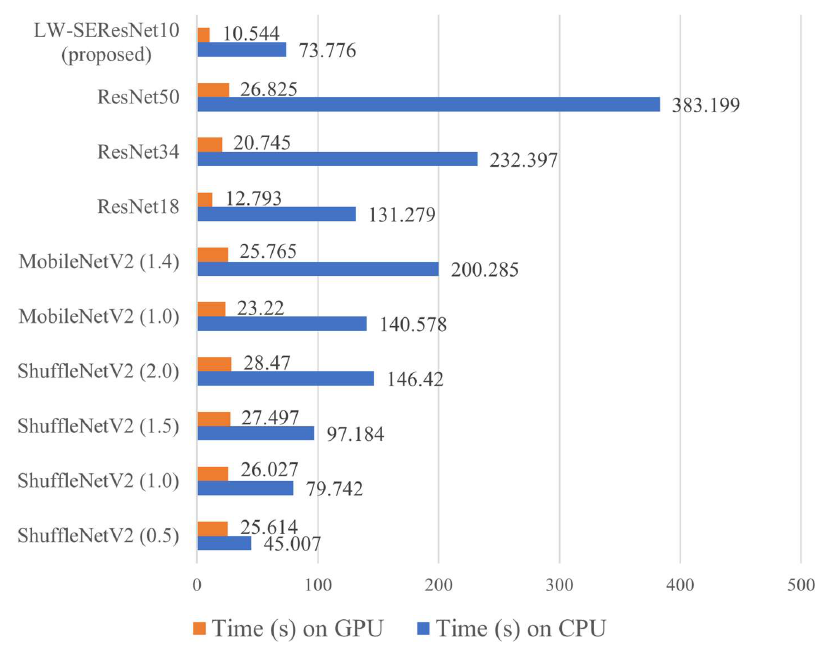
Figure 8. The training time of multiple models under the 3D dynamic MFCC feature.